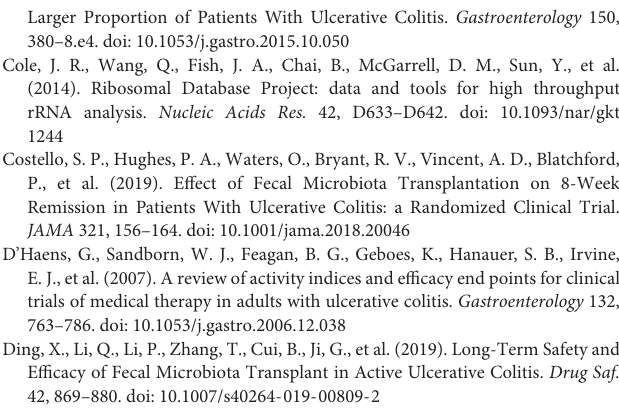
Supplementary Figure 1 | Improvement of intestinal mucosa lesions and histopathological images of PUC2 after two FMT treatments. F0, before FMT; F1, 2 months after the first FMT; F2, 5 months after the first FMT. PUC2, 40y, male, disease course: 15 years, extensive UC (E3), glucocorticoids (60 mg) for 2 weeks combined with mesalamine (4 g) more than 4 weeks did not respond well. Supplementary Figure 2 | Comparisons of alpha diversity among UC patients with different FMT outcomes. Shannon index and Chao1 index are compared among UC patients (A,B) at baseline as well as (C,D) post-FMT with one-way ANOVA. NR, no response; Rel, relapse; Res, responders;